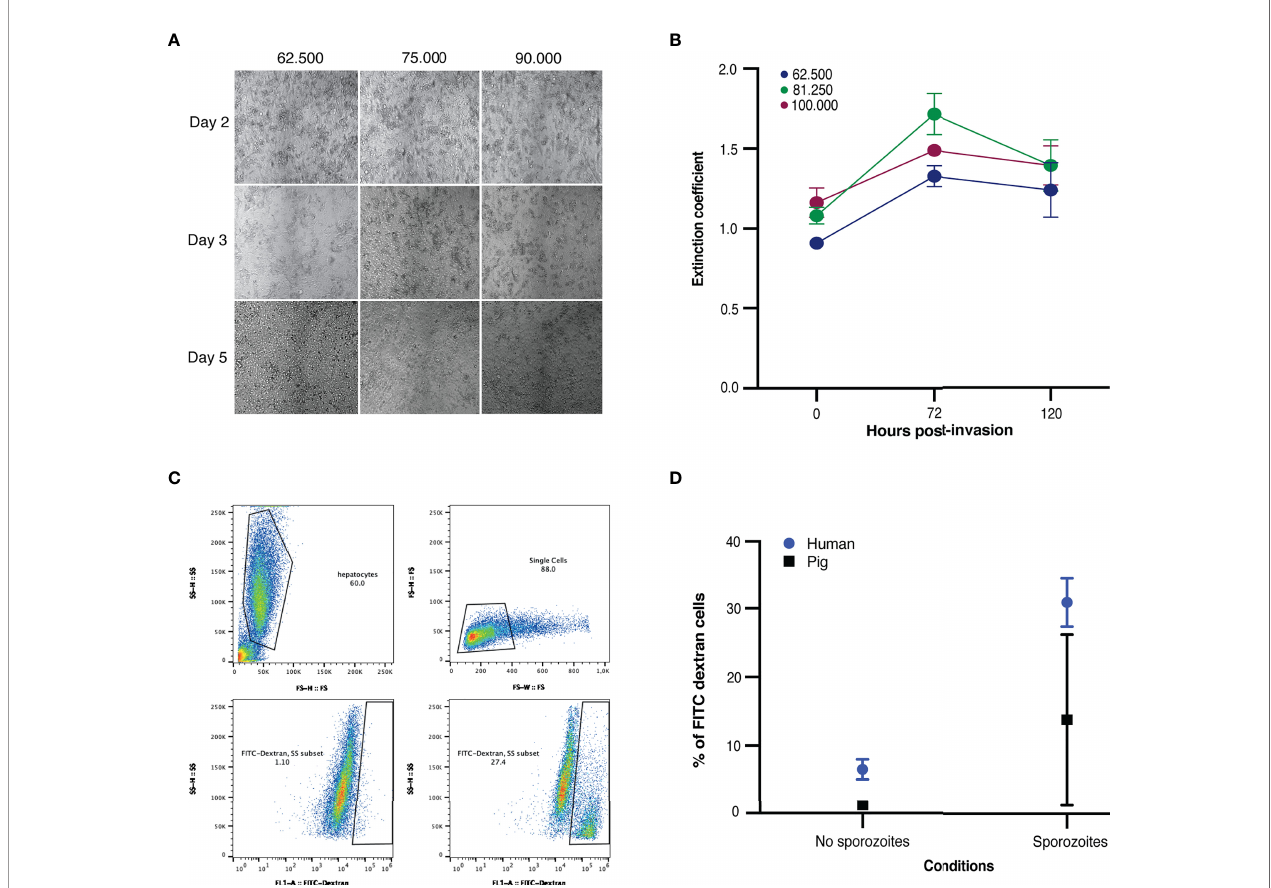
FIGURE 1 | (A) Microscopic images of freshly seeded porcine hepatocytes at 62.500, 75.000 and 90.000 hepatocytes per well on days two, three and fi ve post- invasion. (B) Viability of freshly isolated porcine hepatocytes. Porcine hepatocytes were seeded at densities of 62.500, 81.250 and 100.000 hepatocytes per well. MTT levels are depicted of uninfected control hepatocytes on day three, day fi ve, and day seven post-invasion. Mean MTT reading and standard deviation of four technical replicates of two biological replicates. The extinction was measured at a wavelength of 570 nm. The reference wavelength was set at 630 nm. (C, D) Traversal of NF135.C10 sporozoites in fresh human and porcine hepatocytes three hours post-invasion of three biological donors, each with three technical replicates. (C) Fluorescence activated cell sorting gating strategy used to study traversal. Top left panel: selection of hepatocytes. Top right panel: selection of single cells. Bottom left panel: hepatocytes incubated in FITC-Dextran only (negative control). Bottom right panel: hepatocytes incubated with FITC-Dextran and sporozoites. For both bottom panels, the y-axis shows the degree of FITC-positivity in the cells. For all panels, each dot represents a cell/event measured. (D) Mean percentage (± SD) of traversed porcine and human